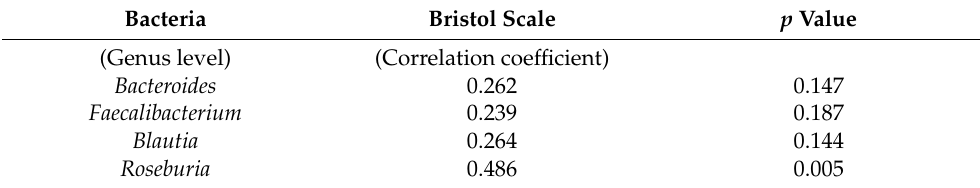
Table 5. Correlation of gut microbiota and Bristol